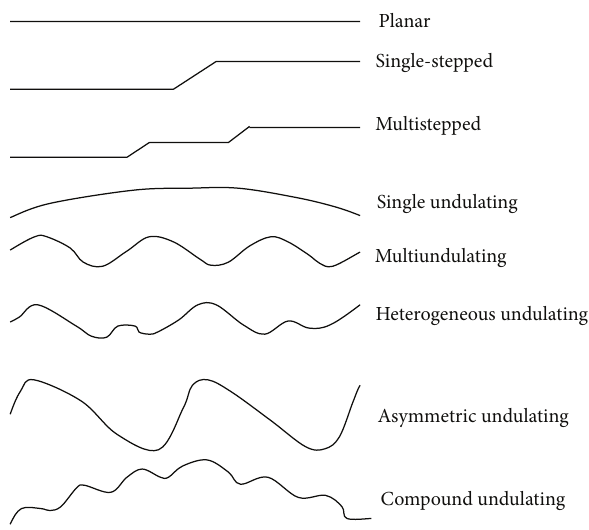
(2) Stepped: to rock joint with stepped surface undulating shape, its relative amplitude 𝑅 𝐴 is more than 1/200.